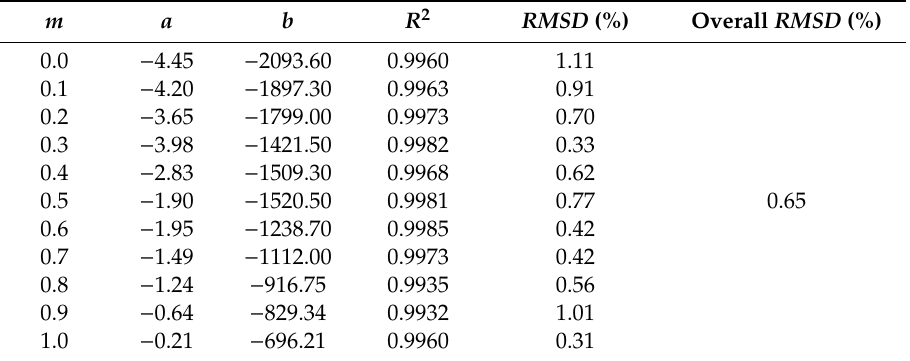
Table 3. Results of “Van’t Ho ff model” for PPN in “THP + water” combinations ( m ) b